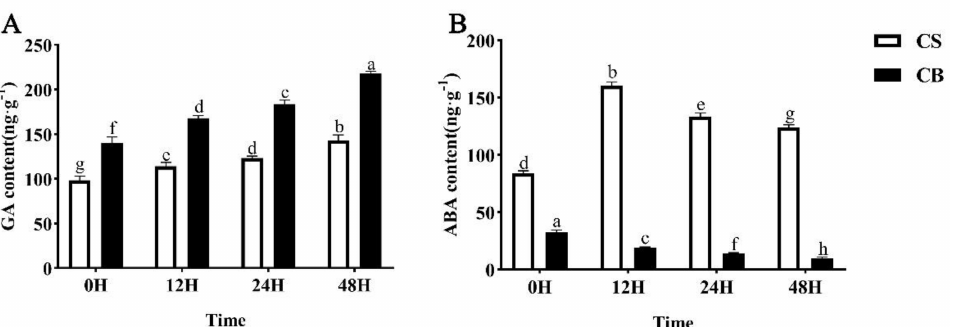
Figure 4. Effects of melatonin on phytohormones under salt stress in cotton seeds. ( A ) Gibberellin (GA) content, ( B ) Abscisic acid content (ABA) content. Different lowercase letters indicate significant differences at the 0.05 probability level ( p < 0.05) according to Tukey’s multiple range tests. Ver-tical bars indicate the mean calculated for three replications. CS: germination of seeds pretreated with just water under 14 ◦ C cold stress; CB: germination of seeds pretreated in 10 mmol/L of GB under 14 ◦ C cold